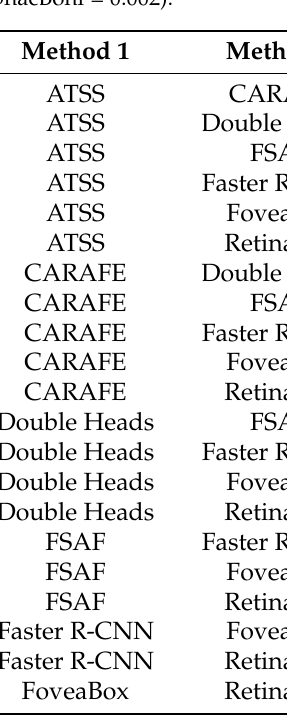
Table 6. Multiple comparison Holm–Bonferroni test (FWER = 0.05, alphacSidak = 0.00, and alphacBonf =